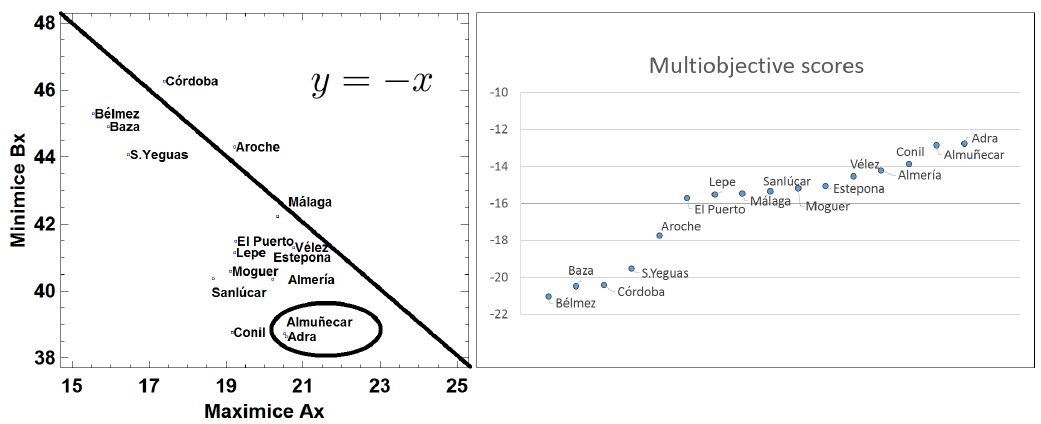
Figure A5. ( left ) Sites considering Ax and Bx and the function y = − x . The places with high values of Ax (max) and low values of Bx (min) are the best locations for the solution of the multiobjective problem (round). ( right ) Multiobjective scores values obtained for each site projecting the point in the function y = − x . High values of this score indicate better places to locate the tourism rural inn.